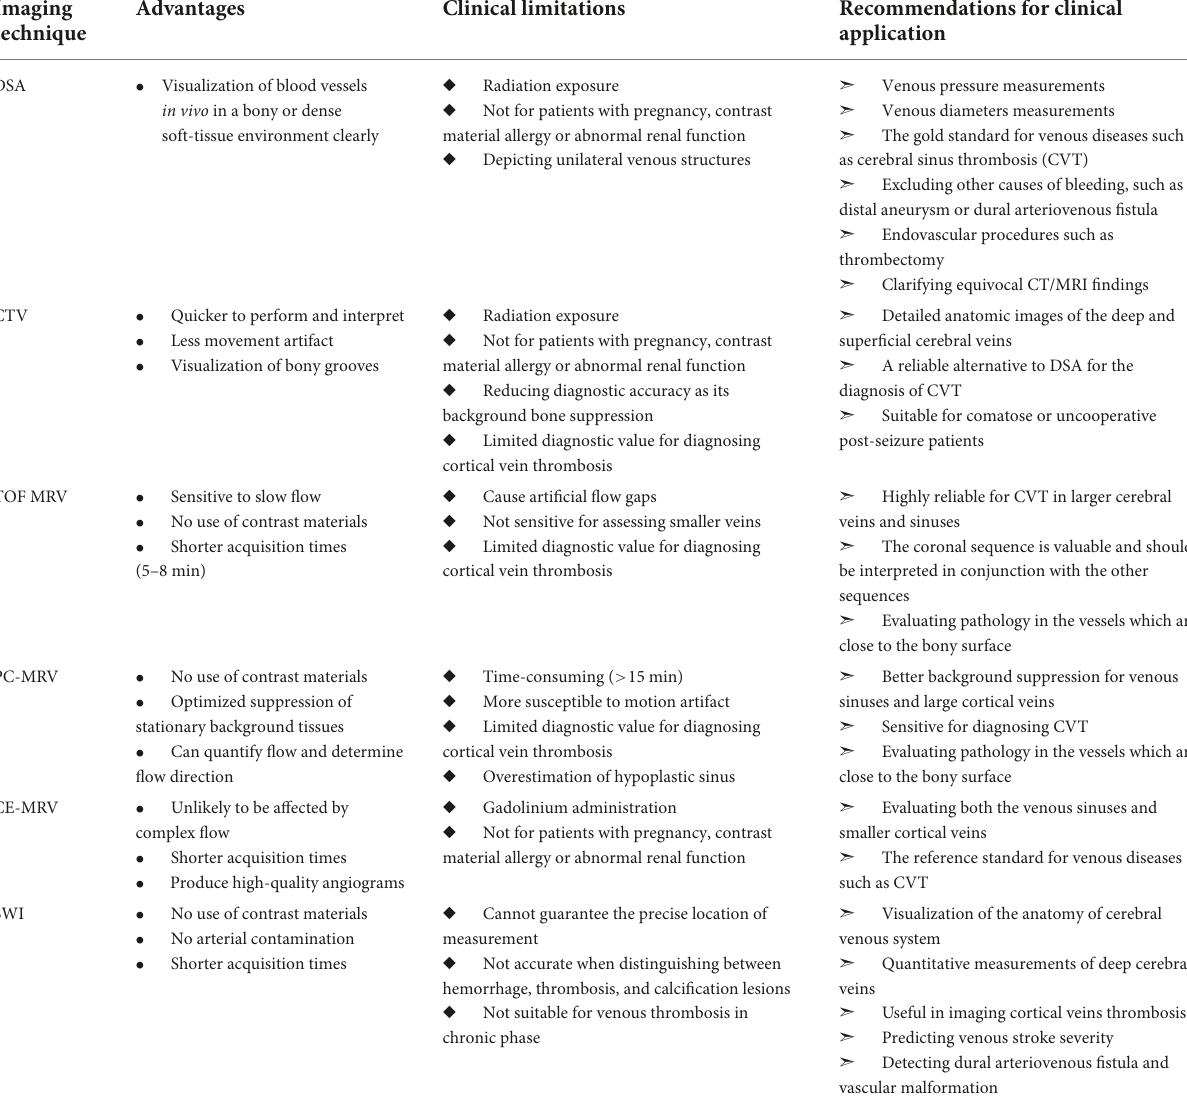
TABLE 7 Summary of advantages, clinical limitations, and application recommendations of usual imaging techniques for cerebral venous system. Imaging